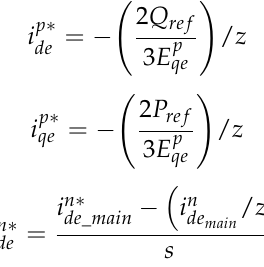
3. PSCAD/EMTDC Simulation Modeling Figure 7 shows the PSCAD/EMTDC simulation modeling of the entirety of Floreana Island. A 140 kW diesel power plant, 200 kW PV plant and 900 kWh ESS were designed. In addition, it was designed in detail considering the actual line length and power load. As mentioned above, the phase C load is the largest, composed of about 46% of the total load. In Figure 7, it can be seen that the phase C load is the largest even in the three phase indications. Additionally, in this study, the diesel generator was not reflected in the com- puter analysis result because BESS operates to provide voltage and frequency to the sys- tem.